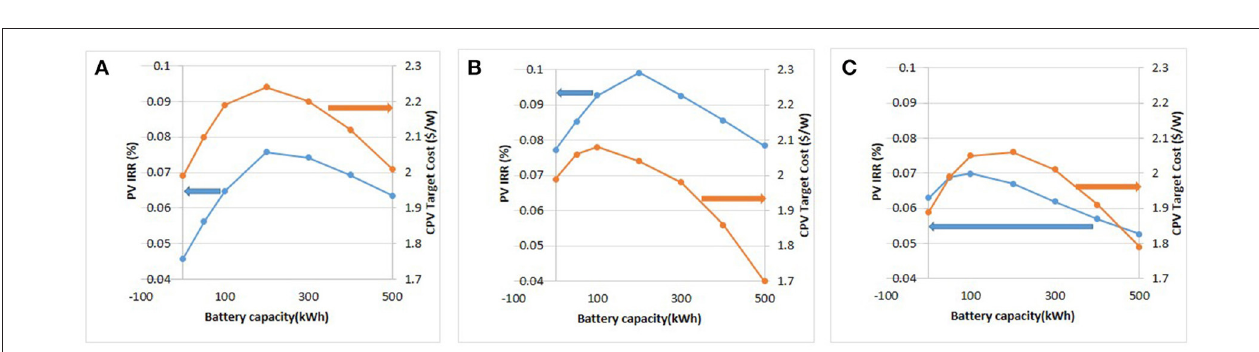
FIGURE 8 | PV IRR (blue graph, left axis) and CPV target cost to match the maximum PV IRR (orange graph, right axis) for Las Vegas (A) 8a.m. 9a.m. 5 p.m. load (C) empirical −